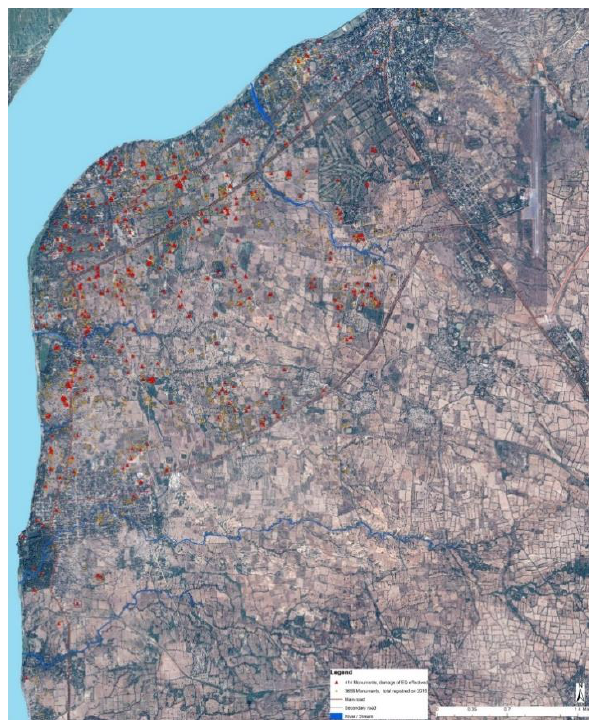
Figure 3 Map of Bagan, Myanmar. The map includes the three main areas of Bagan: the lively town of Nyaung U, the historic walled city of Old Bagan and further on the south the New Bagan (Bagan